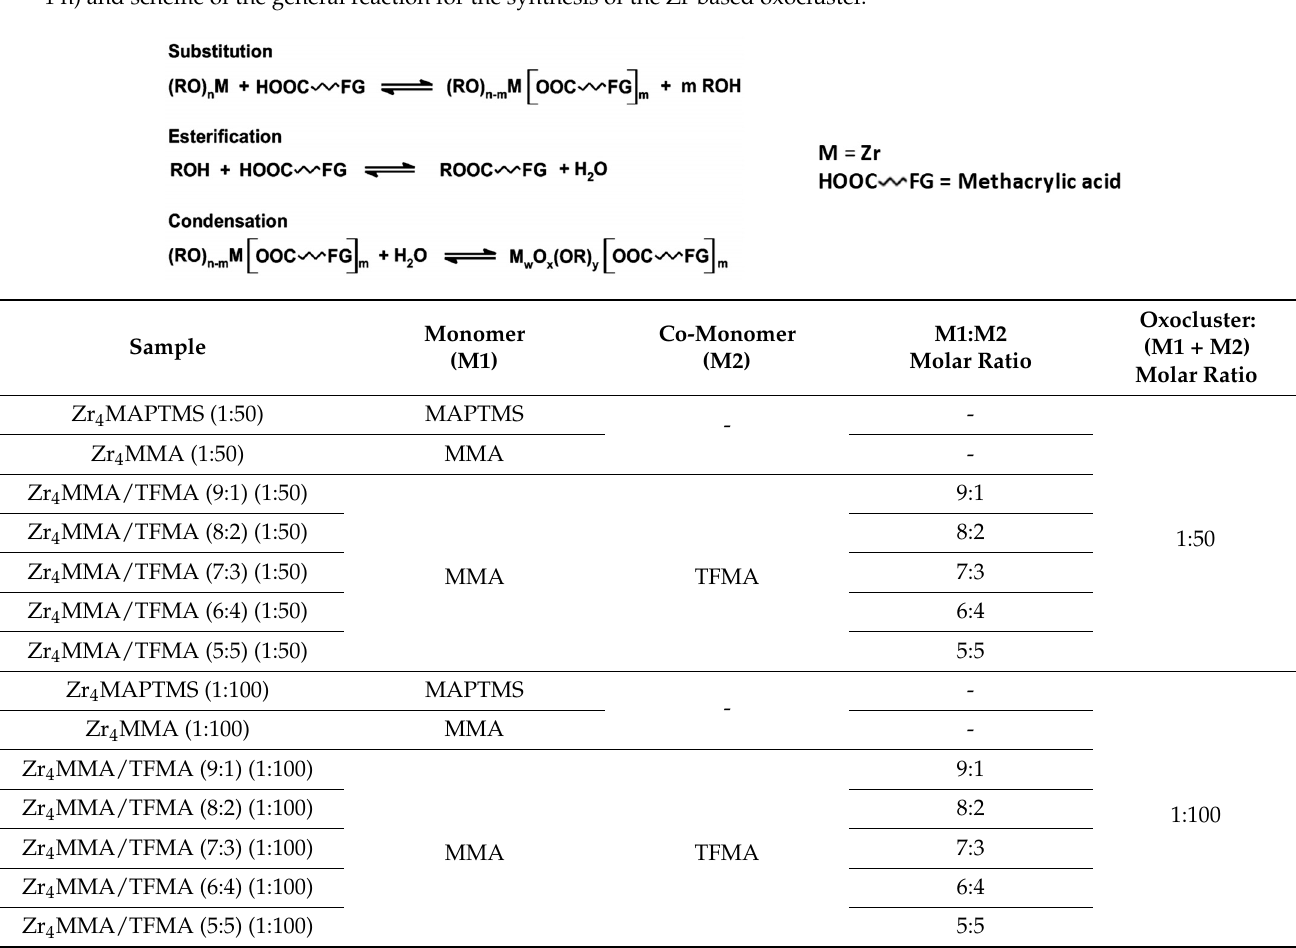
Table 1. List and names of the hybrid materials based on Zr 4 -oxocluster, prepared with 1:50 or 1:100 oxocluster:monomers molar ratio (benzoyl peroxide was used, in all cases, as radical initiator and the polymerisation was carried out at 85°C for 1 h) and scheme of the general reaction for the synthesis of the Zr-based oxocluster.